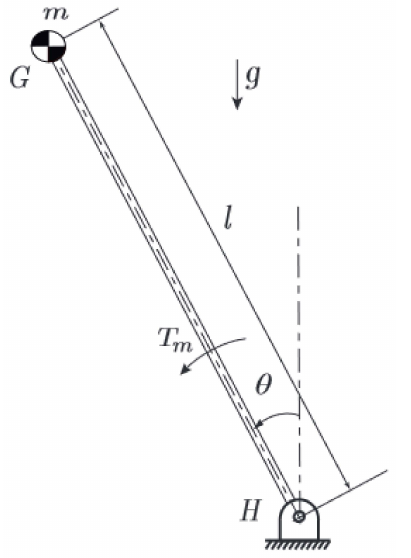
Figure 3. Inverted Pendulum [17].